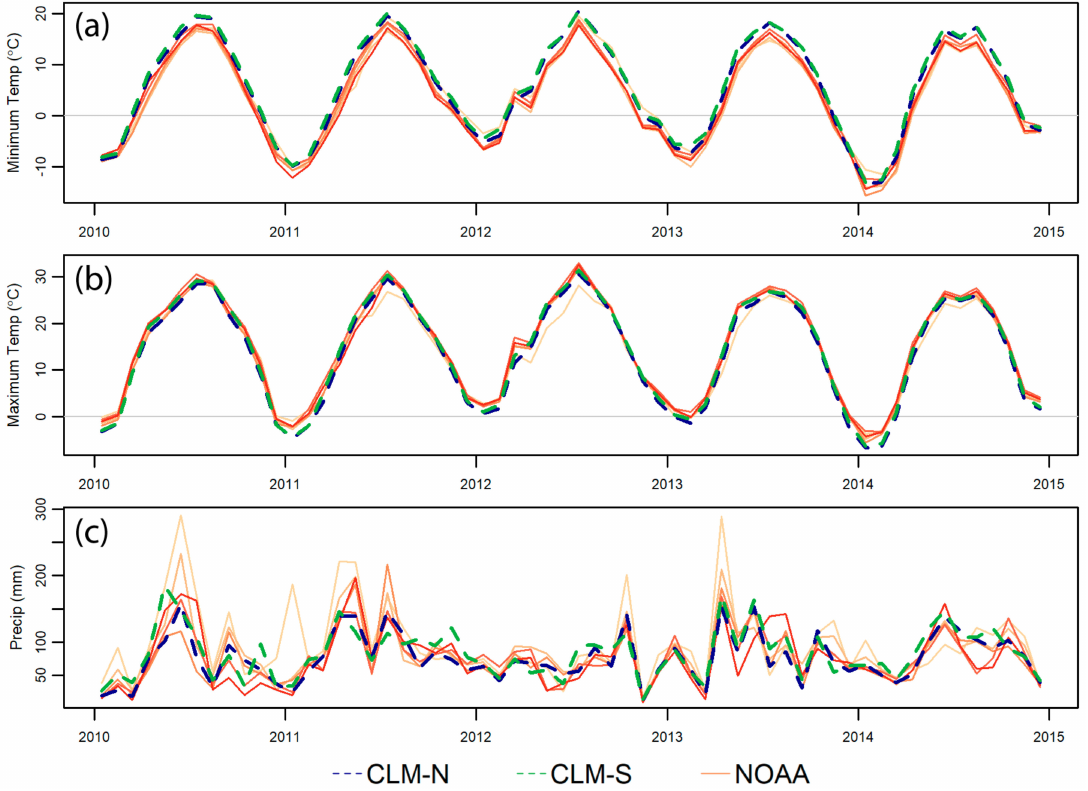
Figure 4. Comparison of average monthly minimum temperature ( a ), monthly maximum temperature ( b ), and total monthly precipitation ( c ) values for the five years surrounding 2012. Station data are warm solid lines—each line represents a di ff erent